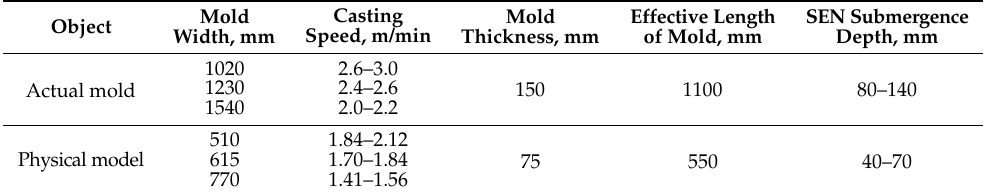
Table 2. Parameters of actual and experimental